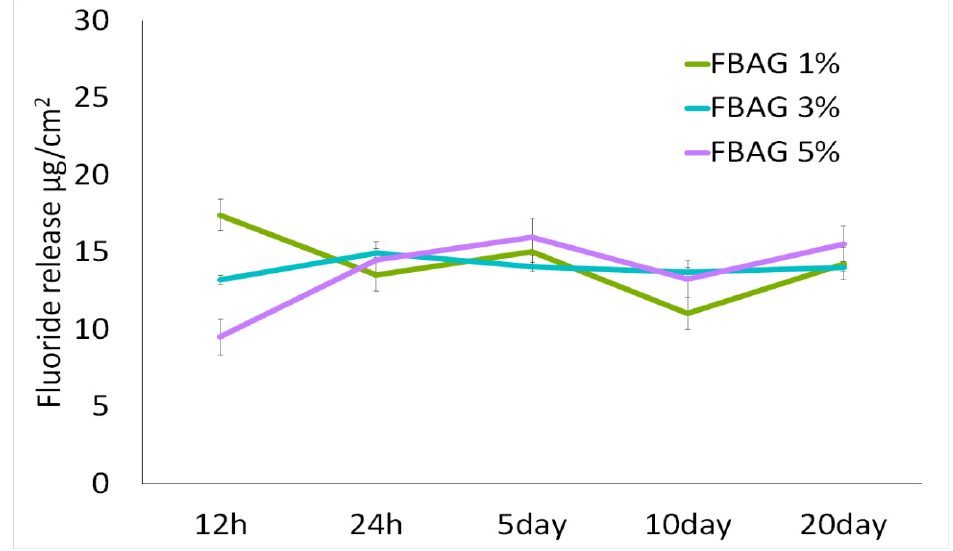
Figure 9. Fluoride release from FBAG1, FBAG3, and FBAG5. Resin disks of diameter 5 mm and thickness 2 mm were prepared and used.